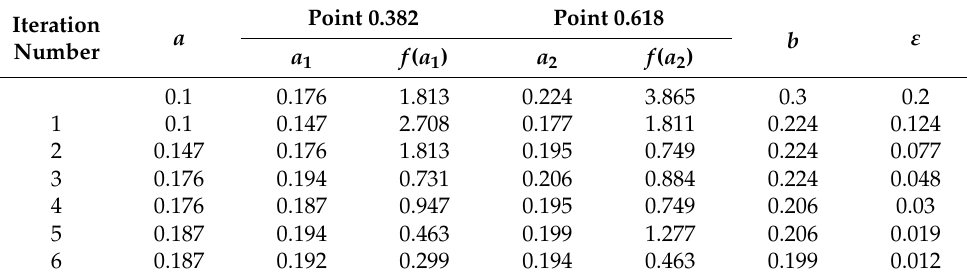
Table 3. Golden section method iteration process.